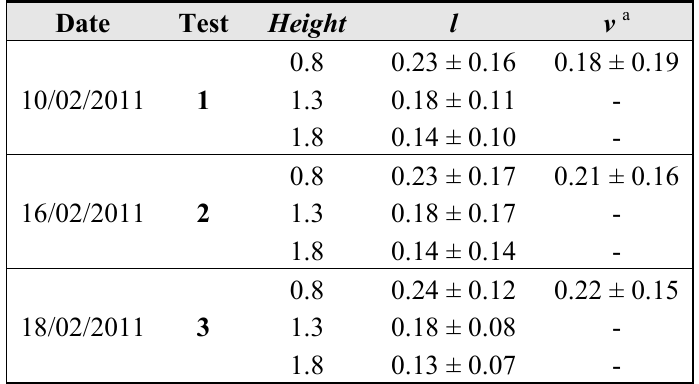
Table 2. Inside average values of two-dimensional horizontal resultant of air velocity in the XY plane l [m∙s −1 ] and the XZ plane v [m∙s −1 ]; height